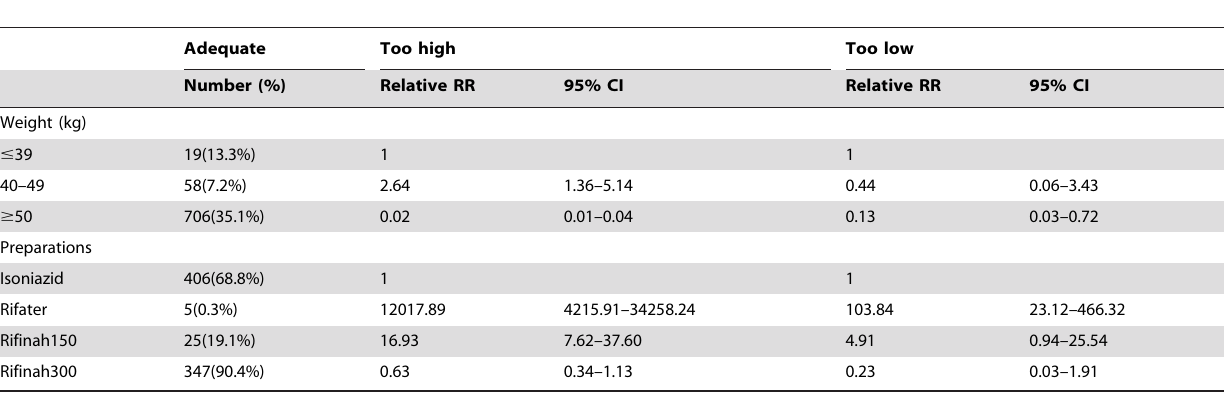
Table 3. Factors associated with inadequate dosing of isoniazid among patients treated with Rifater, Rifinah or isoniazid in single- drug preparation, 2007–2010, Taipei.